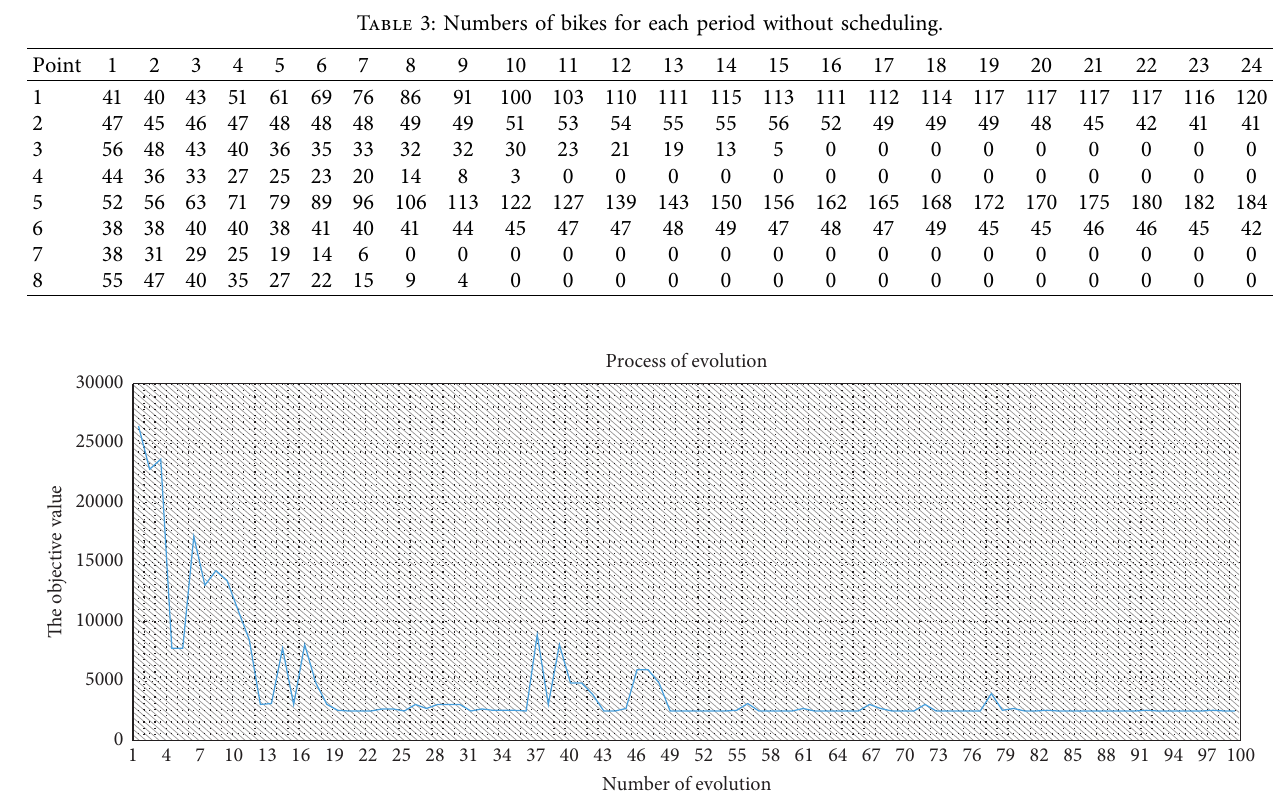
Figure 4: Process of evolution.